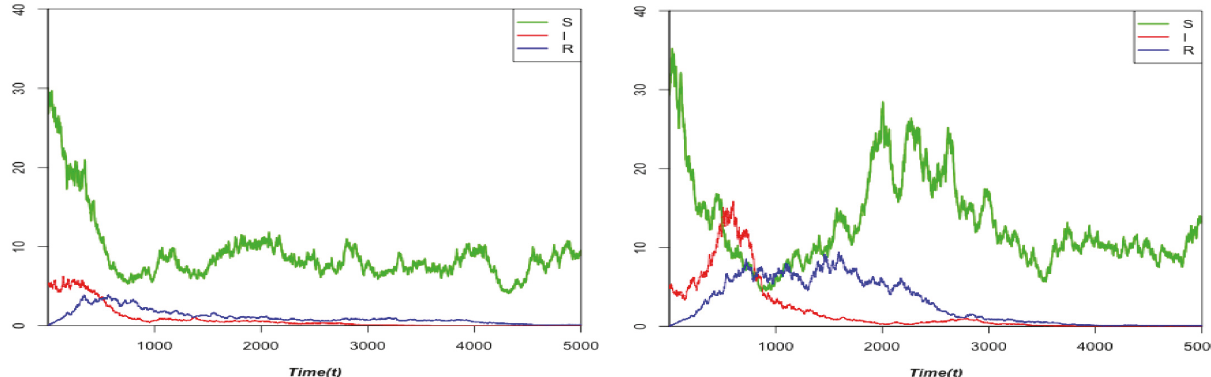
Figure 1: The numerical simulation of one path of the solution (𝑆 𝑡 , 𝐼 𝑡 , 𝑅 𝑡 ) of the system (3) using the Milstein scheme with ( 𝜎 = 0.035 left), ( 𝜎 = 0.35 right) and the parameters values Λ = 1 , 𝛽 = 0.01 , 𝜇 1 = 0.066 , 𝜇 2 = 0.066 , 𝜇 3 = 0.0666 , 𝛼 = 0.16 , 𝜎 1 = 0.2 , 𝜎 2 = 0.25 , and 𝜎 3 = 0.21. In this situation R 𝑇 = 0.59 < 1. Hence, the disease will die out.